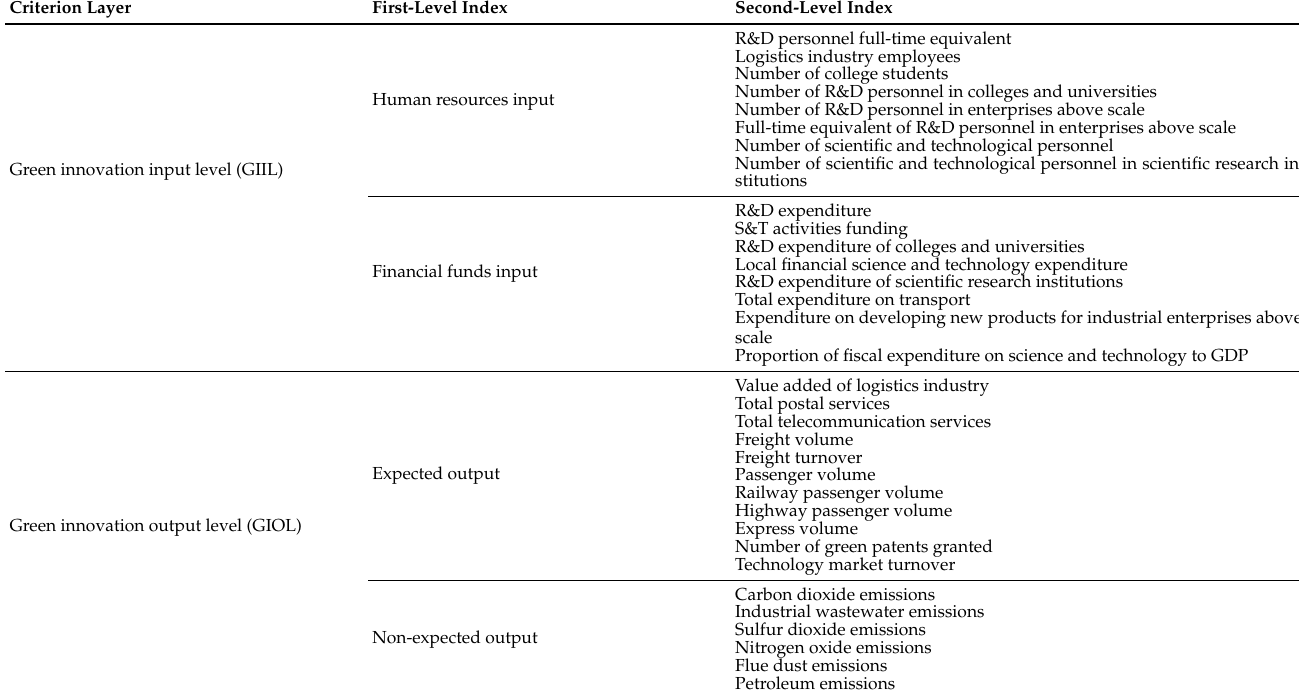
Table 1. Regional logistics green innovation level evaluation index primary